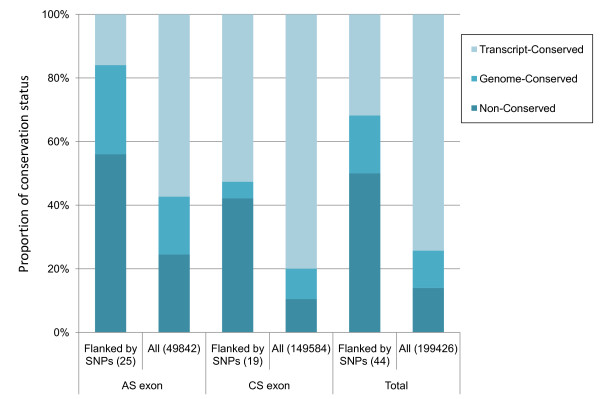
Graph showing proportions of conservation statuses of exons in human and mouse genome. Human exons were categorized according to conservation status of mouse homologous exons. A non-conserved exon is a human exon that does not align with a mouse genomic region using a threshold of 70% for coverage and 60% for identity. A genome-conserved exon is a human exon whose alignment with a mouse genomic region exceeds the above thresholds. A transcript-conserved exon is a human exon whose alignment with a mouse transcript exceeds the threshold [51]. Numbers shown at "Flanked by SNPs" and "All" in each category on the horizontal axis are numbers of genomic regions of sdSNPs (Process 7 in Figure 2) and of all exons in the human genome (Panel A of Table 1 in [51]).